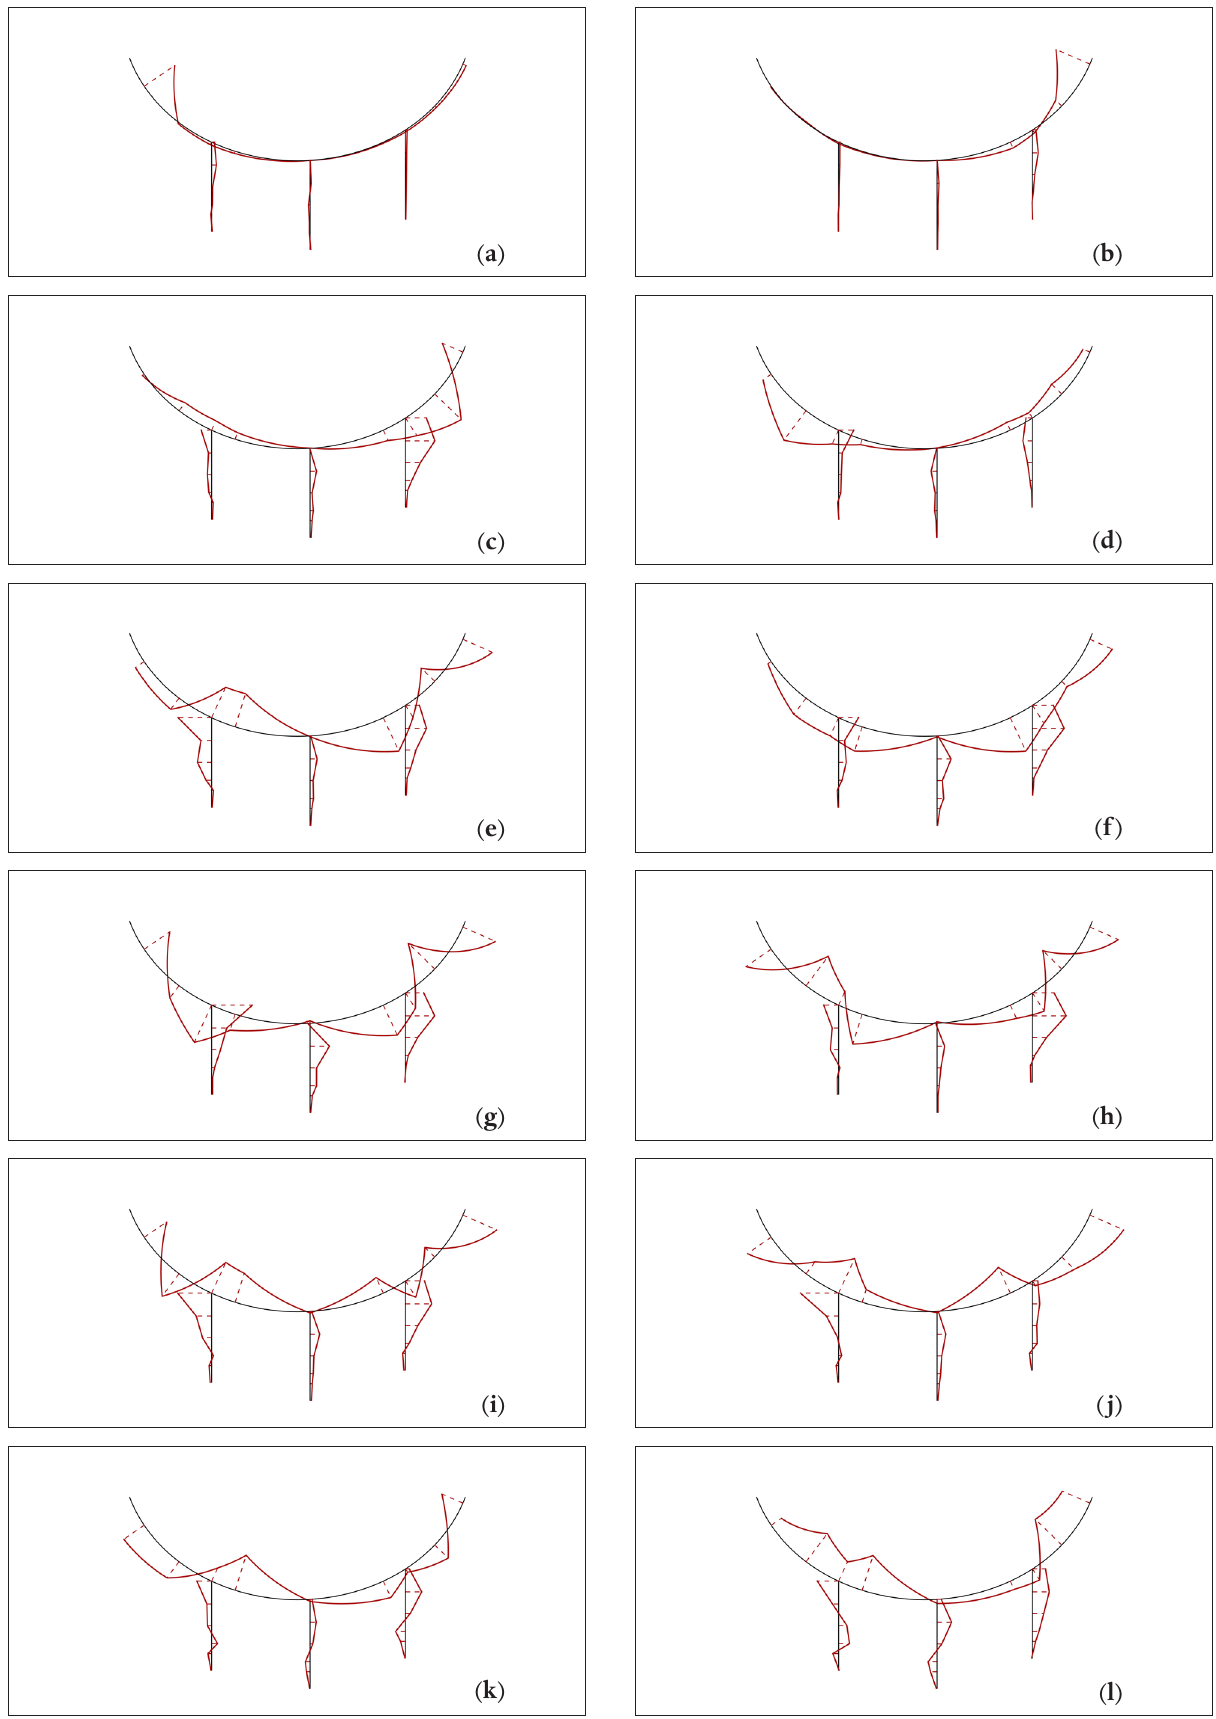
Figure 14. Modal